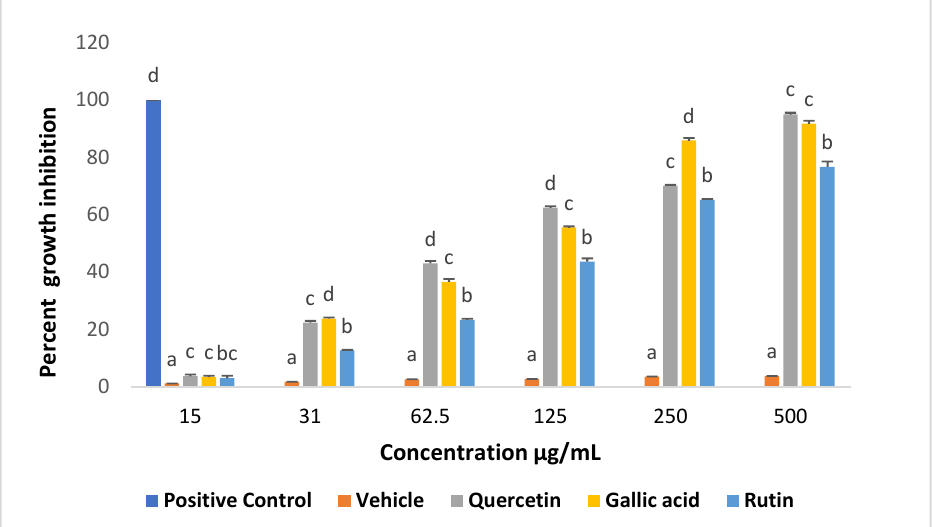
Figure 1. Percent growth inhibition of the Leishmania (Ds-Red L. donovani strain LV82) promastigotes caused by quercetin, gallic acid, and rutin at concentration equal to their IC 50 (µg/mL) values. Data represent the mean values of three replicates with ± standard error. Different labels on columns show significant difference at p < 0.05 .